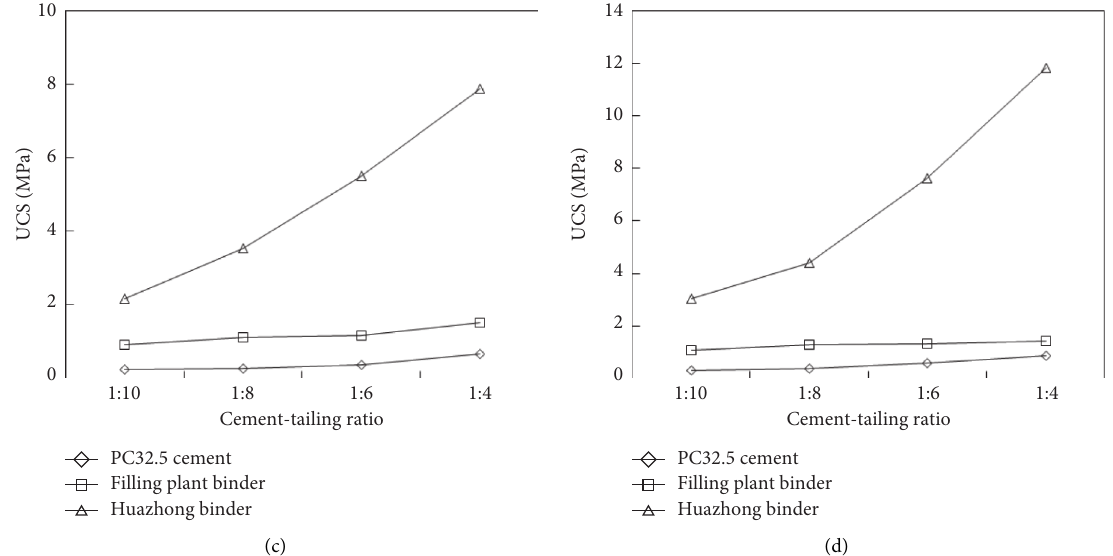
Figure 6: Variation of UCS with b/t. (a) 3d curing time. (b) 7 d curing time. (c) 28d curing time. (d) 60d curing